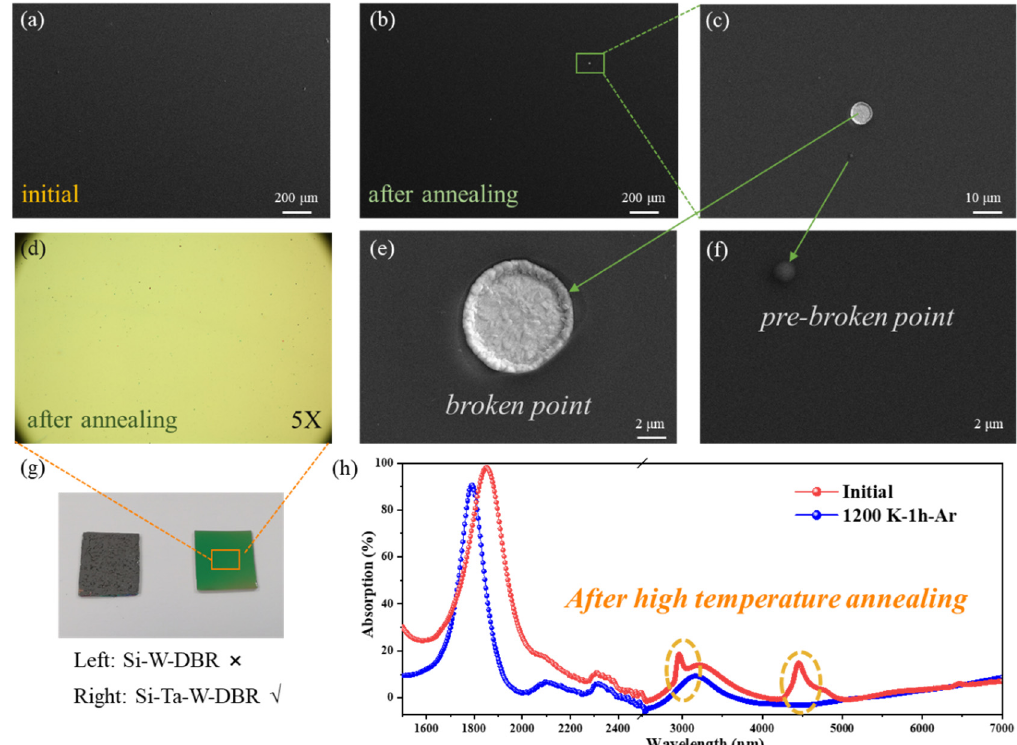
Figure 4. Morphology characterizations of Si-W-SiN/SiNO emitter before and after 1200 K annealing treatment; ( a ) SEM characterizations of initial Si-W-SiN/SiNO emitter with a magnification of 50; ( b – f ) optical microscopy and SEM characterizations of Si-W-SiN/SiNO emitter after 1200 K annealing for 1 h, with a magnification of 5, 50, 1000 and 5000, respectively; ( g ) digital photograph of Si-W-SiN/SiNO emitters after 1200 K annealing for 1 h with and without an adhesive layer; ( h ) experimental optical absorption spectra of fabricated Si-W-SiN/SiNO emitters before and after annealing at 1200 K in Ar atmosphere for 1 h.